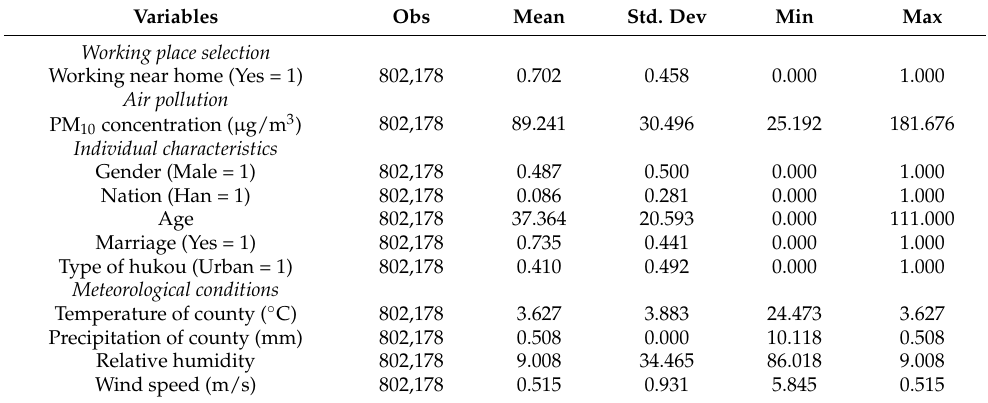
Table A2. Robustness to using the alternative air pollution measure